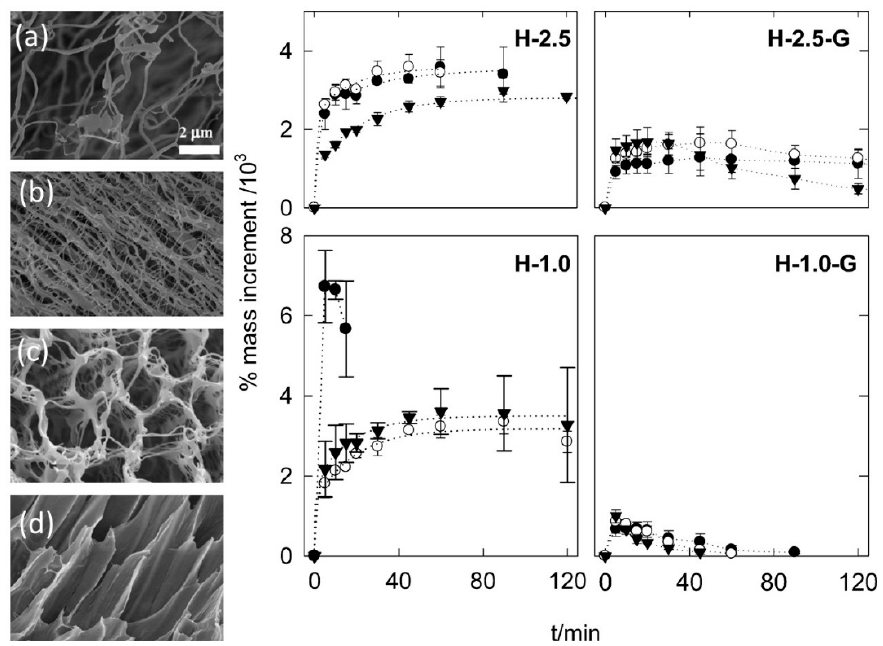
Figure 13. Left panel ( a – d ): SEM images (perpendicular to the freezing direction) of HA hydrogels produced by ice-segregation-induced self-assembly with different freezing rate (FR): H-0.1, FR = 3.6 mm min –1 ( a ), H-0.5, FR = 48 mm min –1 ( b ), H-1.0, FR = 1.8 mm min –1 ( c ), and H-2.5, FR = 48 mm min – 1 ( d ). Scale bars depicted for sample ( a ) are valid for all the images. Right panel: Swelling behavior of native HA control samples containing 2.5 and 1 wt.% of HA (labeled as H-2.5 and H-1.0, respectively) and the HA samples loaded with extra content of G (labeled as H-2.5-G and H-1.0-G, respectively) frozen at 1.8 ( ▼ ), 3.6 ( ○ ), and 48 ( ● ) mm min –1 . G refers to Gentamicin. From [90]. (cid:35) Table 2. Summary of antiseptic / antibiotic release systems based on HA. Please see text and cited references for